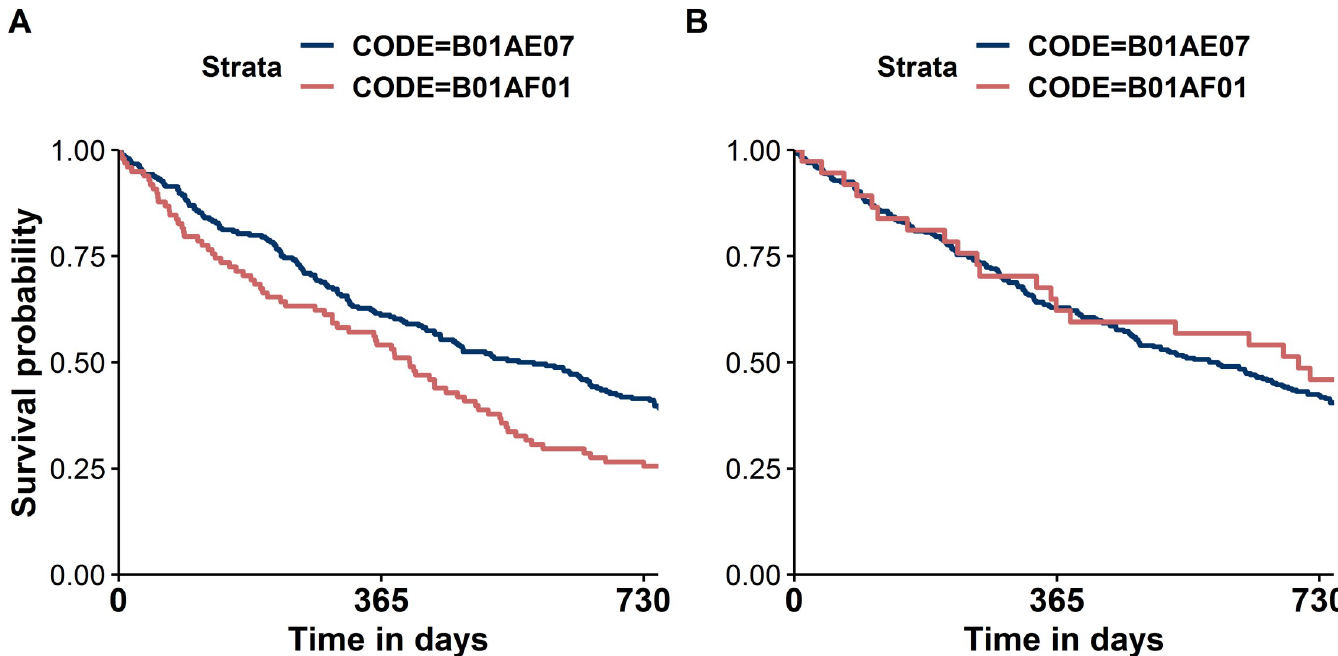
Fig 3. Kaplan-Meier plots comparing overall survival between two treatments (ATC codes B01AE07 and B01AF01 in personalized precision cohorts trimmed for Patient 1 (A) and Patient 2 (B)).